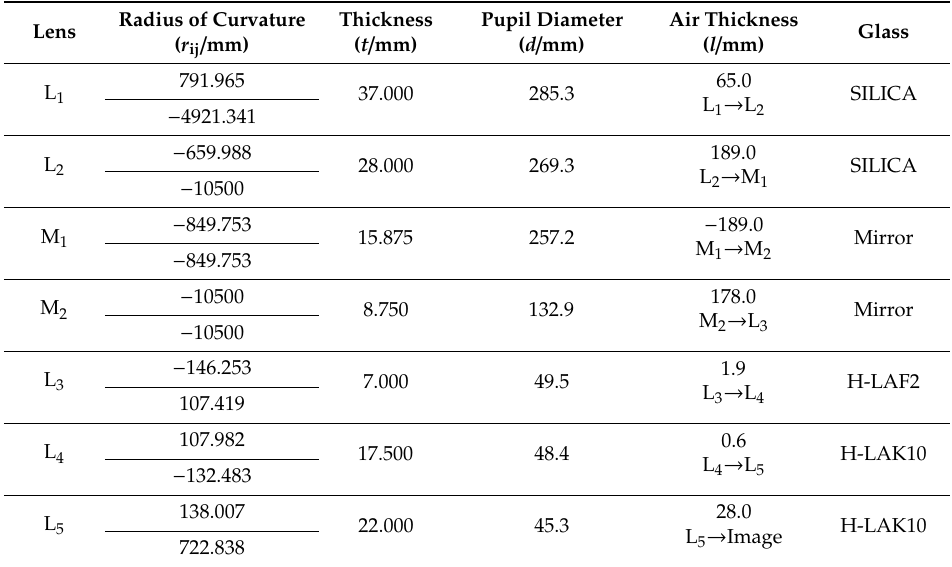
Table 4. Optimized parameters of the catadioptric optical system (COS).